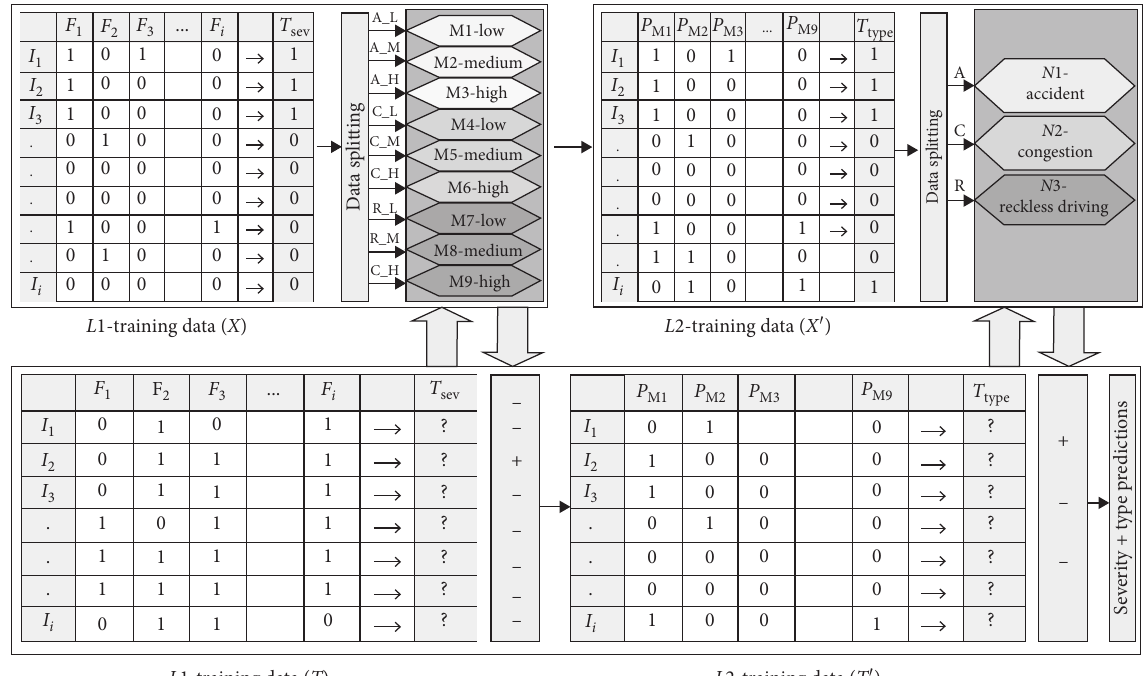
Figure 3: Elaborated view of the proposed classification algorithm.